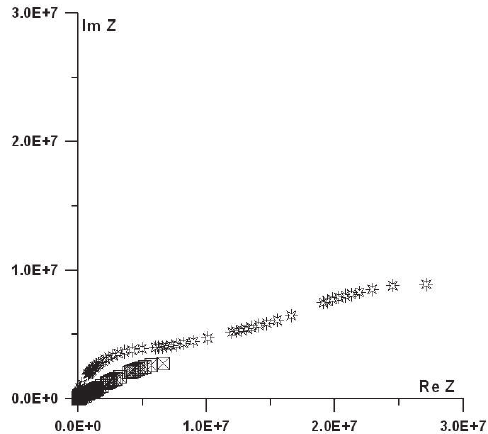
Fig. 5. The complex resistivity plane representation of the sample for relative saturations 4% ( ), 8% ( ), 11% ( ), 14% ( ), respectively.